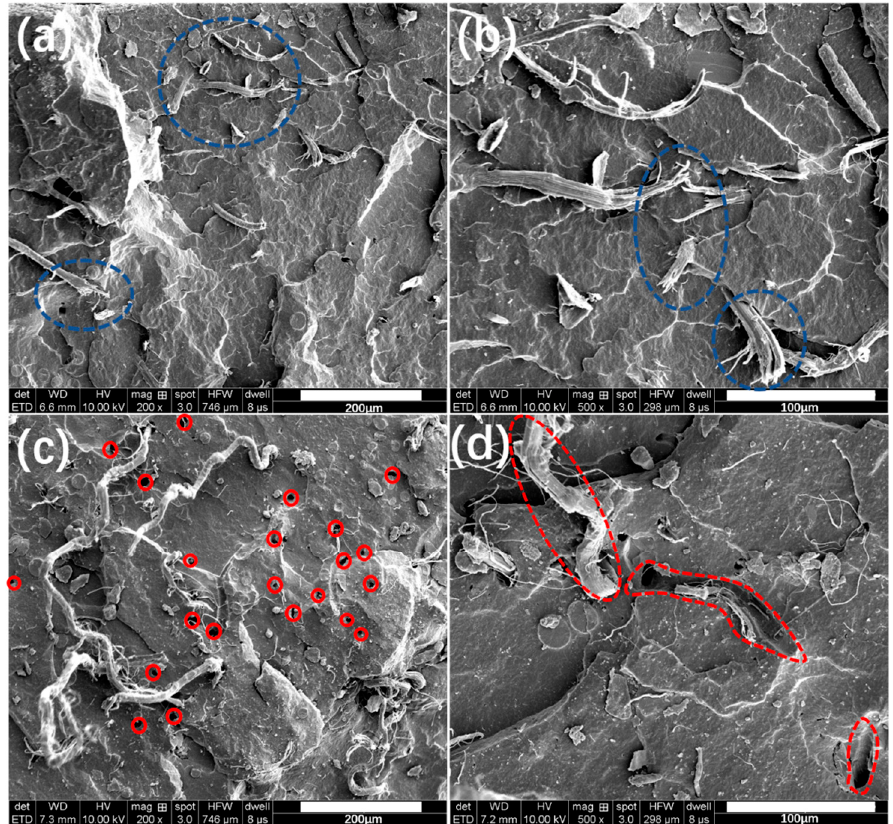
/ NR ( a , b ) and SiO 2 @AF